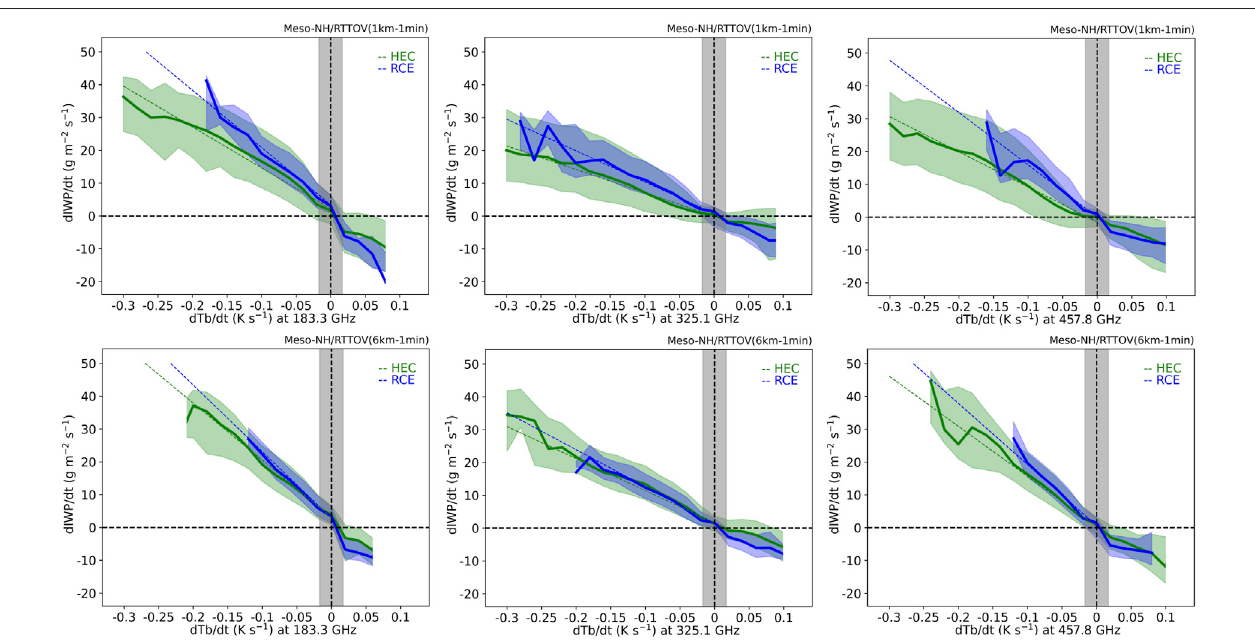
FIGURE8| dIWP/dtasafunctionofdTb/dt forthe183.3,325.1,and457.8 GHzchannels(fromlefttoright)atthehorizontal resolutionofthesimulations(top)and at a linearly interpolated 6-km pixel resolution (bottom). The time delay of the satellite tandem is 1 min. The bin interval is 0.02 K s − 1 . The median (bold lines), the interquartile range (shadings), and the least squares regression (dashed lines) are shown for HEC (green) and RCE (blue). The grey band delimits a dTb/dt uncertainty of 0.017 K s − 1 ,correspondingtoa1 KuncertaintyintheTbmeasurementfora1-mindelayinthesatellitetandem.Resultsareshownforgridpointsverifyingthedeep convection criterion.